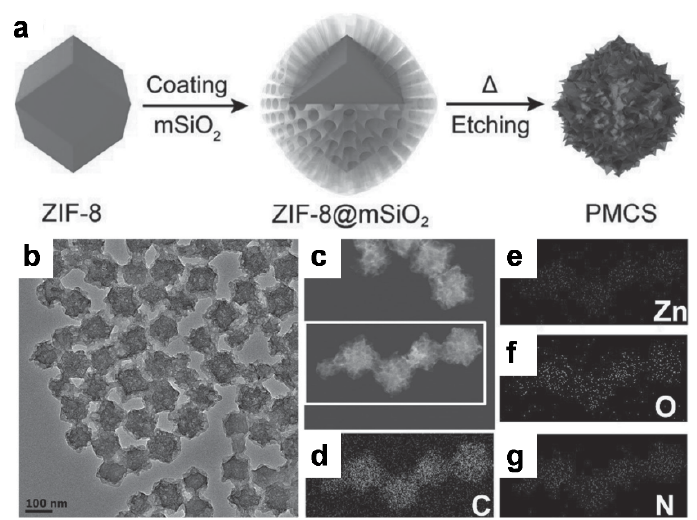
Figure 14. Synthesis and characterization data for mesoporous carbon nanospheres containing porphyrin-like metal centers (PMCS). ( a ) Scheme for PMCS synthesis; ( b ) TEM and ( c ) STEM images, scale bar is 100 nm. Element mapping for ( d ) carbon, ( e ) zinc, ( f ) oxygen, and ( g ) nitrogen. Reproduced with permission from [123]. Copyright, John Wiley and Sons (2016).